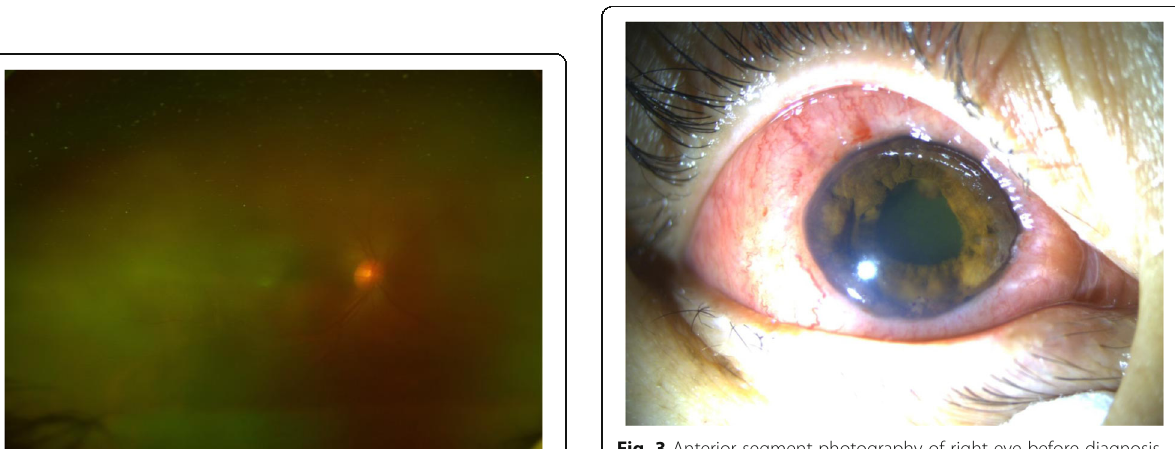
Fig. 3 Anterior segment photography of right eye before diagnosis vitrectomy showed swelling conjunctiva, irregular ridgy iris and edge of mass in the vitreous